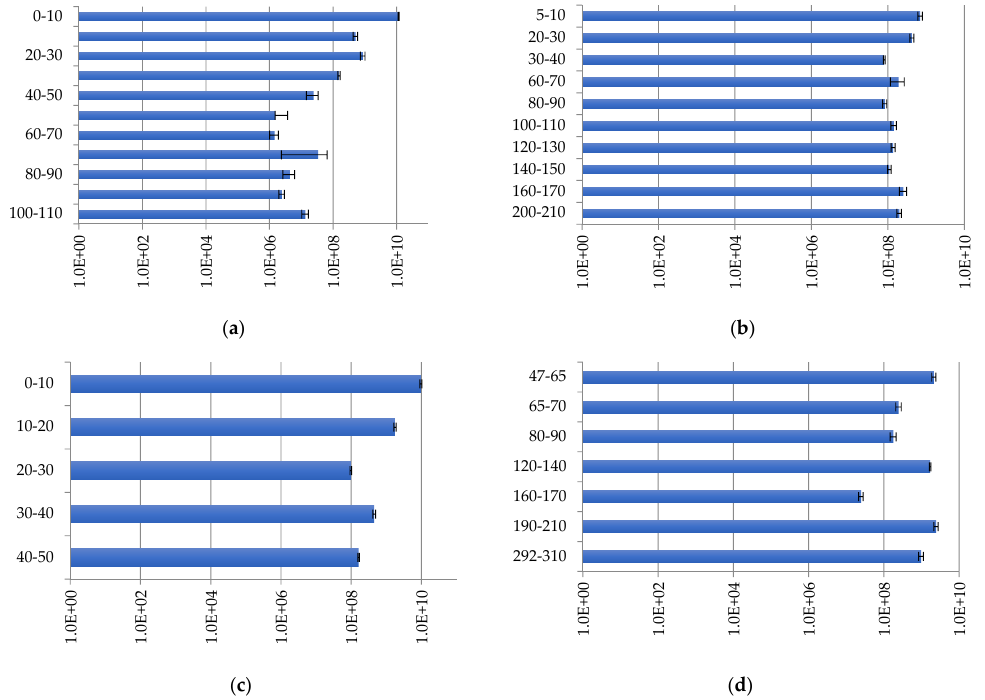
Figure 5. Fungal distribution (copies/g of soil) in peat strata: ( a ) Inta 1; ( b ) Kolva; ( c ) Inta 11; and ( d ) Voda-Ty. At site Kolva, the maximum number of fungal ribosomal operons is 7.02 × 10 8 ± 9.61 × 10 7 copies/g of soil, which was found in the 5 – 10 cm layer, and the minimum number is 8.02 × 10 7 ± 4.11 × 10 6 copies/g of soil, found at a depth of 30 – 40 cm (Figure 5b). At site Inta 11, the number of copies of the 18S rRNA ribosomal genes of microscopic fungi varies from 9.69 × 10 9 ± 6.02 × 10 8 copies/g of soil at a depth of 0 – 10 cm, to 9.74 × 10 7 ± 4.98 × 10 6 copies/g of soil at a depth of 20 – 30 cm (Figure 5c).